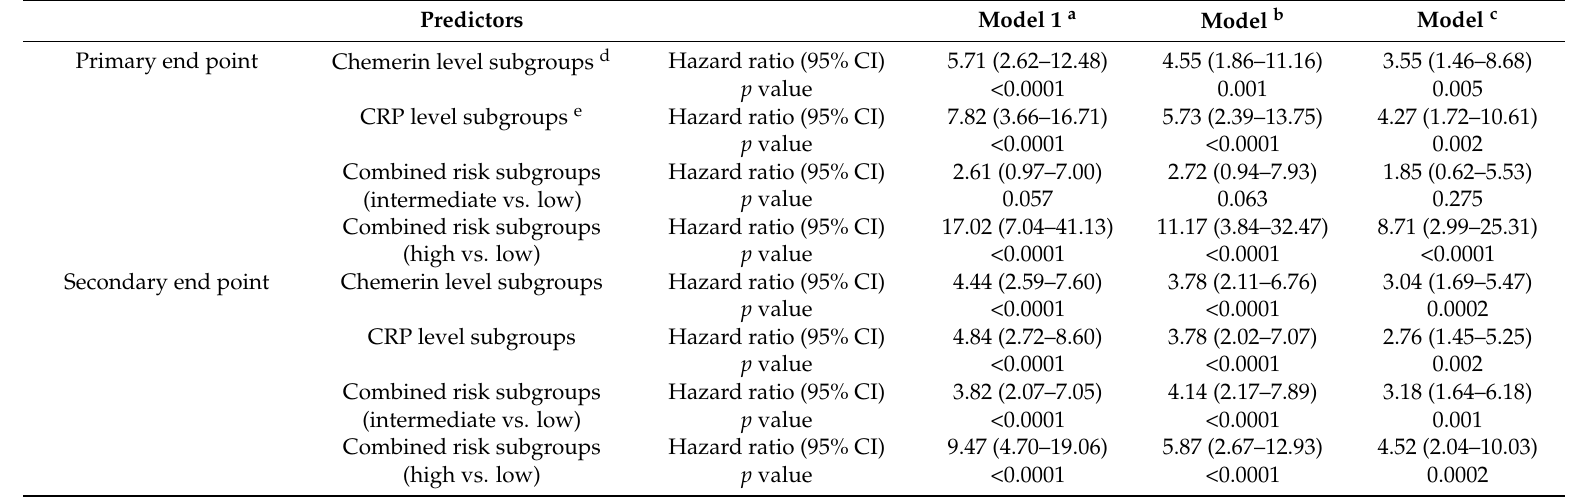
Table 3. Predictors of primary and secondary endpoints in Cox regression